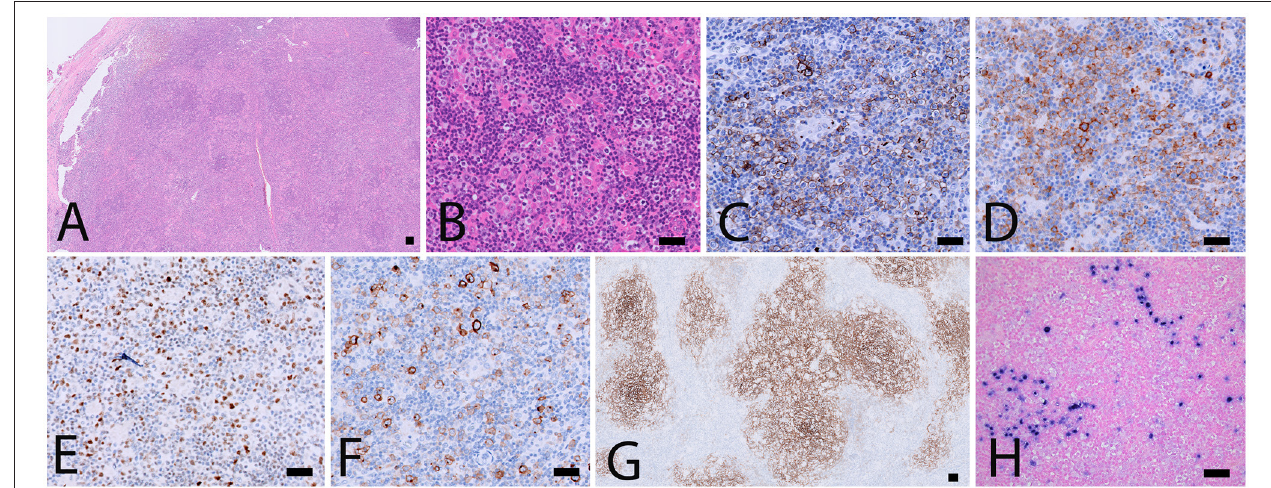
FIGURE 2 | Biopsy specimen. (A,B) H&E stainings showing architectural disturbance due to a medium-sized lymphoid population with a clear cell morphology. (C–F) Immunohistochemical stainings establishing the TFH origin of the abnormal cell population: CD3 + , CD4 + , CD10 + (not shown), ICOS + (C) , PD1 (D) , BCL6 (E) and expression of CD30 (F) . CD21 staining (G) shows an extended network of follicular dendritic cells. (H) Intermediate sized EBV + immunoblasts by EBER in situ hybridization. Scalebar: 100 µ m.